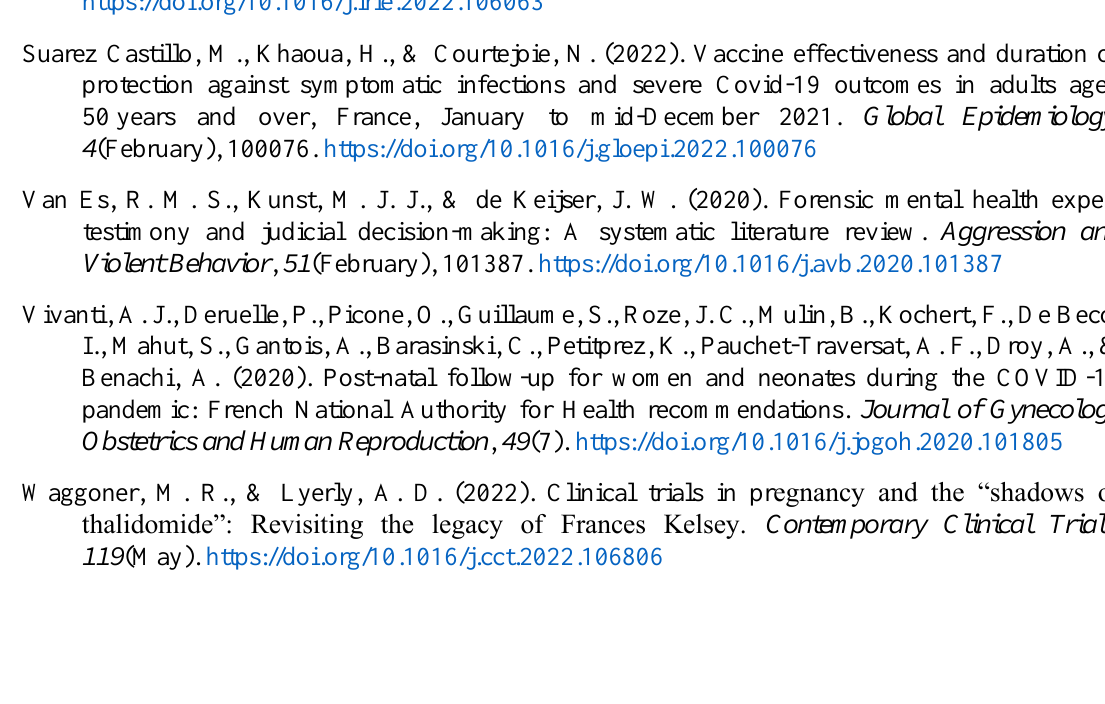
Dewi Nurul Savitri (Legal Policy on the Protection of the